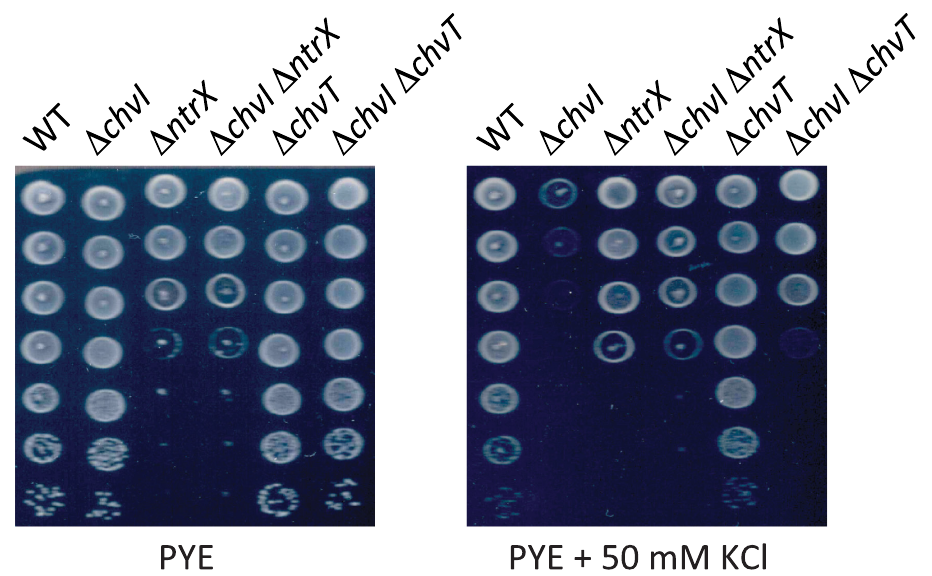
Fig 2. Viability of chvI , chvT and ntrX mutants in hypertonic conditions. Viability of single ( Δ chvI , Δ chvT and Δ ntrX ) and double ( Δ chvI Δ chvT and Δ chvI Δ ntrX ) mutants on PYE agar with or without 50 mM KCl. Images represent three biological